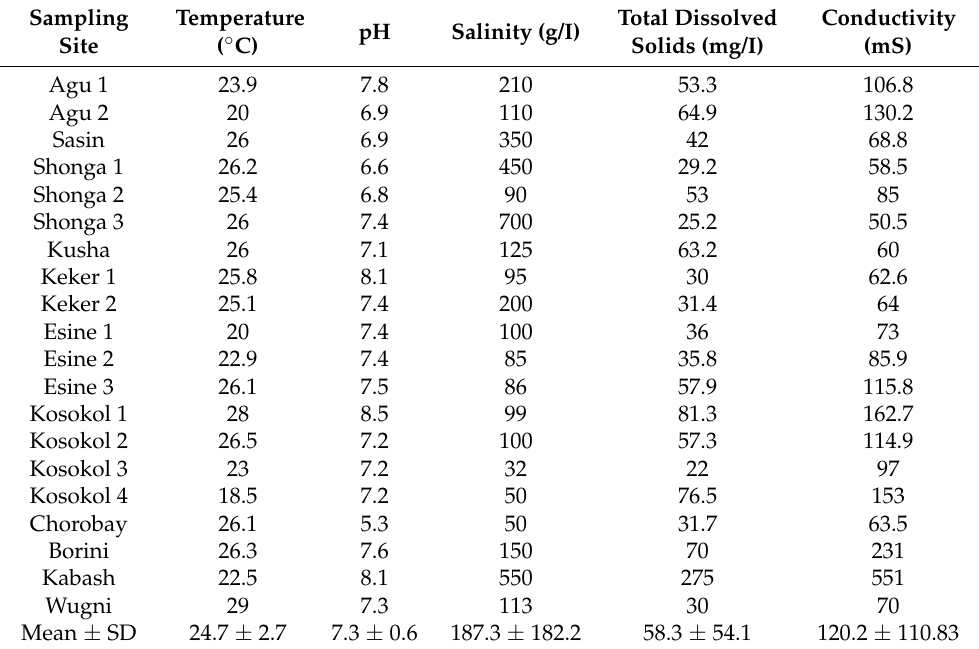
Table 2. Characteristics of the rivers across the sampling sites n =